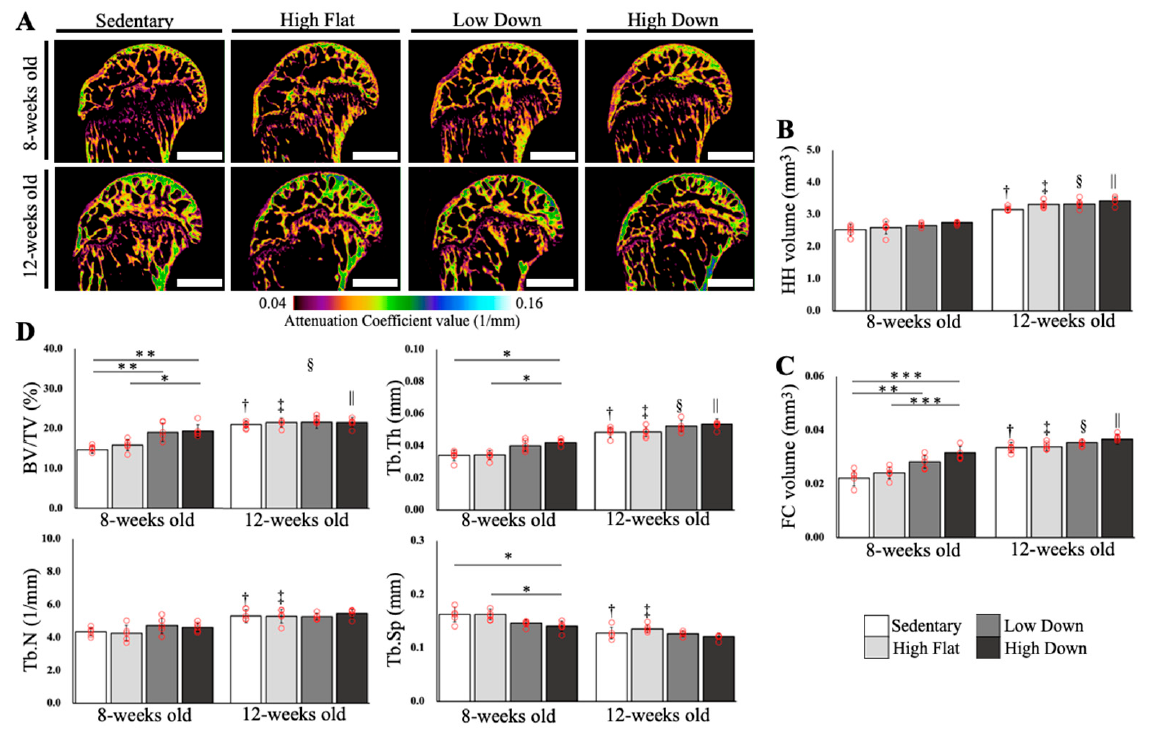
Figure 4. Bone quality evaluation of the humerus head. ( A ) Images of the HH obtained by microCT imaging are shown. Color mapping was performed on the microCT images using the attenuation coefficient (AC) values at the time of imaging as a reference. Scale bar; 1 mm. ( B ) Results of HH volume comparisons. ( C ) Results of the FC volume comparisons. ( D ) Results of bone quality evaluation in the SB region underlying the enthesis CFC area: bone volume/tissue volume (BV/TV), trabecular thickness (Tb.Th), trabecular number (Tb.N), and trabecular separation (Tb.Sp). Statistical significance: * p < 0.05, ** p < 0.01, *** p < 0.001. † p < 0.05 (8-week-old mice in the Sedentary group vs. 12-week-old mice in the Sedentary group), ‡ p < 0.05 (8-week-old mice in the High Flat group vs. 12-week-old mice in the High Flat group), § p < 0.05 (8-week-old mice in the Low Down group vs. 12-week-old mice in the Low Down group), || p < 0.05 (8-week-old mice in the High Down group vs. 12-week-old mice in the High Down group). CT, computed tomography; HH, humerus head; CFC, calci fi ed fi brocartilage.